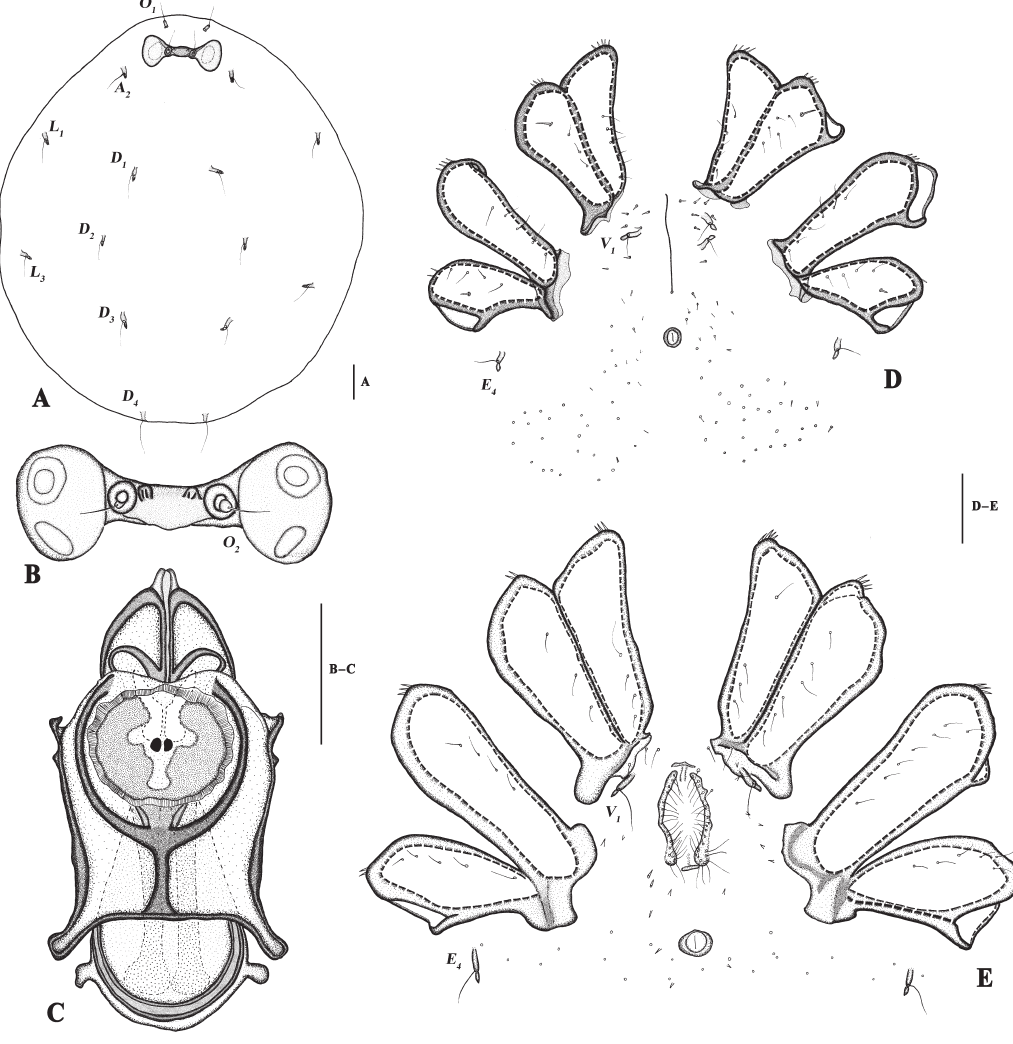
Fig. 1. Eylais ( Meteylais ) hamata Koenike, 1897. A–C, E . ♂ (GUGC QH-EY-20200801). D . ♀ (GUGC QH-EY-20200804). A . Idiosoma, dorsal view. B . Eye plate (with a pair of humps). C . Gnathosoma. D–E . Idiosoma, ventral view. Scale bars = 200